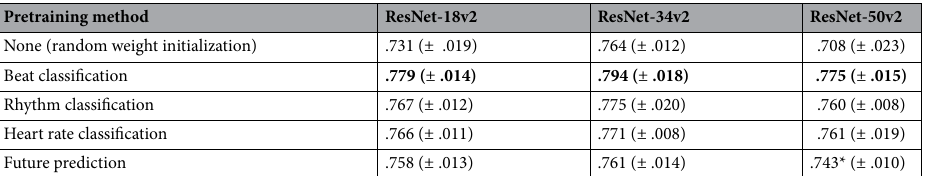
Table 4. Comparison of the pretraining methods depending on the architecture of the model (i.e. residual network). For each method, we report the average macro F 1 score (and the standard deviation) on our test set for the PhysioNet/CinC Challenge 2017 7,8 . Employing the ResNet-34v2 improves the performance of every pretraining method. We suspect that ResNet-34v2 lies in a sweet spot between model complexity and performance, whereas ResNet-18v2 underfits and ResNet-50v2 overfits to the training data. *Due to a spike in the model complexity, we only pretrain the first 3 stages of the